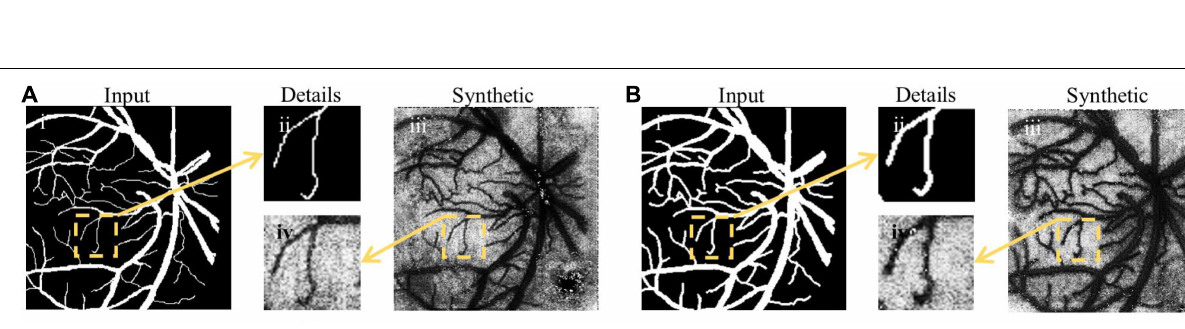
Frontiers in Neuroscience |